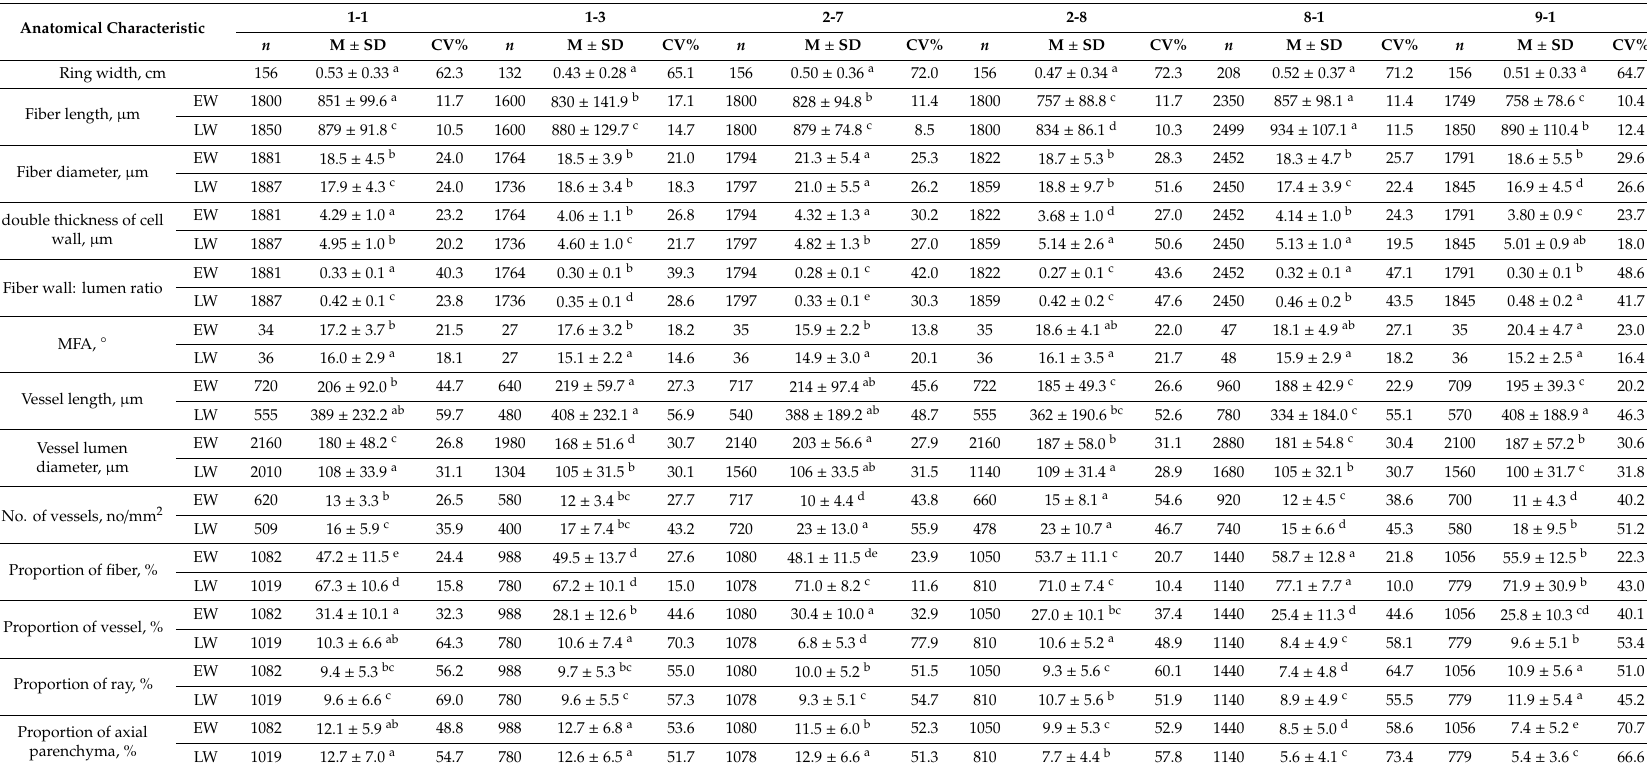
Table 2. Means (M) and standard deviations (SD) of measured anatomical characteristics in six C . bungei